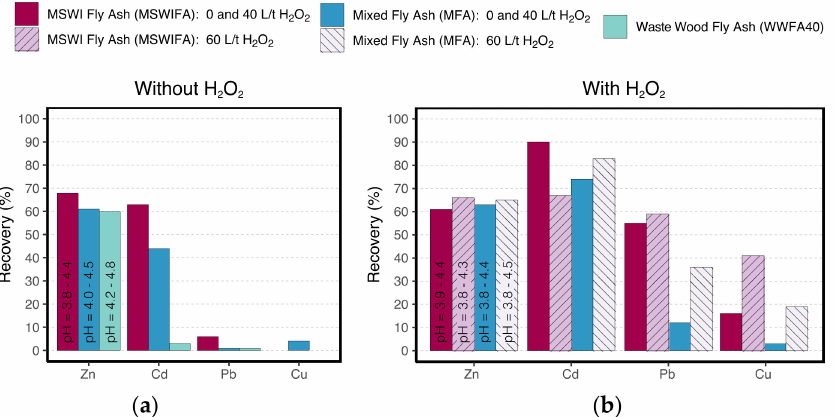
Figure 4. Recovery for the industrial-scale experiments ( a ) without and ( b ) with H 2 O 2 (40 and 60 L/t H 2 O 2 ). The pH of the leachate is indicated in the bar for Zn recovery. The industrial-scale experiments with H 2 O 2 were not performed for